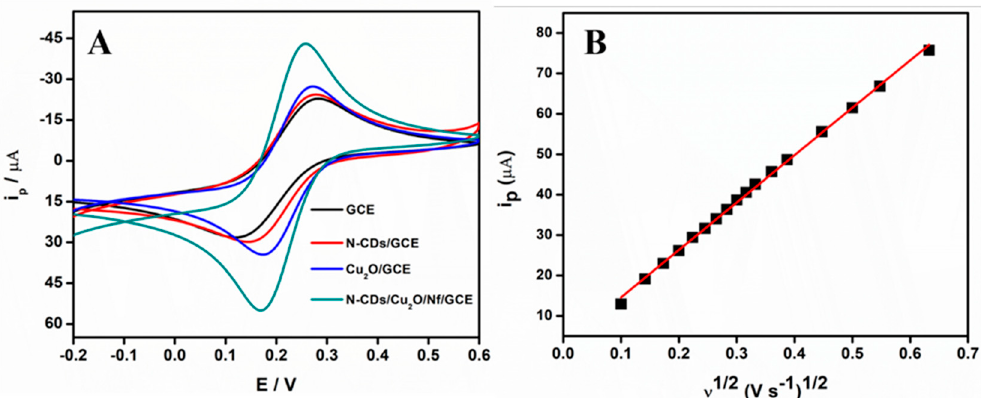
Figure 3. ( A ) Cyclic voltammetric responses of different modified electrodes in 0.1 M KCl containing 2.5 mM [Fe(CN) 6 ] 3 − / 4 − at a scan rate of 100 mV s − 1 , ( B ) Calibration plot of square root of scan rate vs. anodic peak current of 1 mM K 3 [Fe(CN) 6 ] in 0.1 M KCl at N-CDs/Cu 2 O/Nf/GCE.